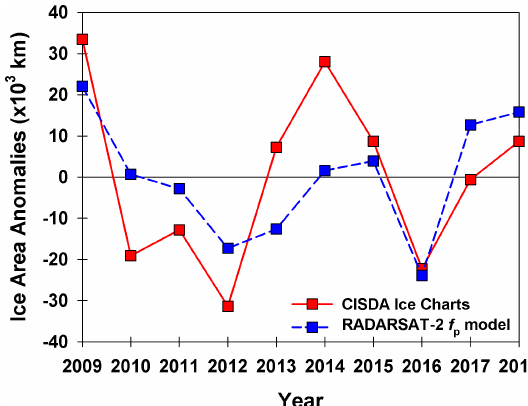
Figure 11. Predicated sea ice area anomalies (detrended) using RADARSAT-2 peak melt pond fraction ( f pk ) and observed sea ice area anomalies (detrended) from the Canadian Ice Service Digital Archive (CISDA) ice charts in the Viscount Melville Sound region of the Canadian Arctic Archipelago,